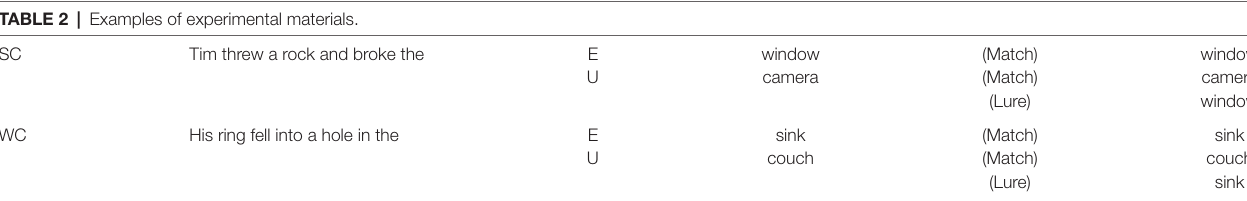
TABLE 2 | Examples of experimental materials.